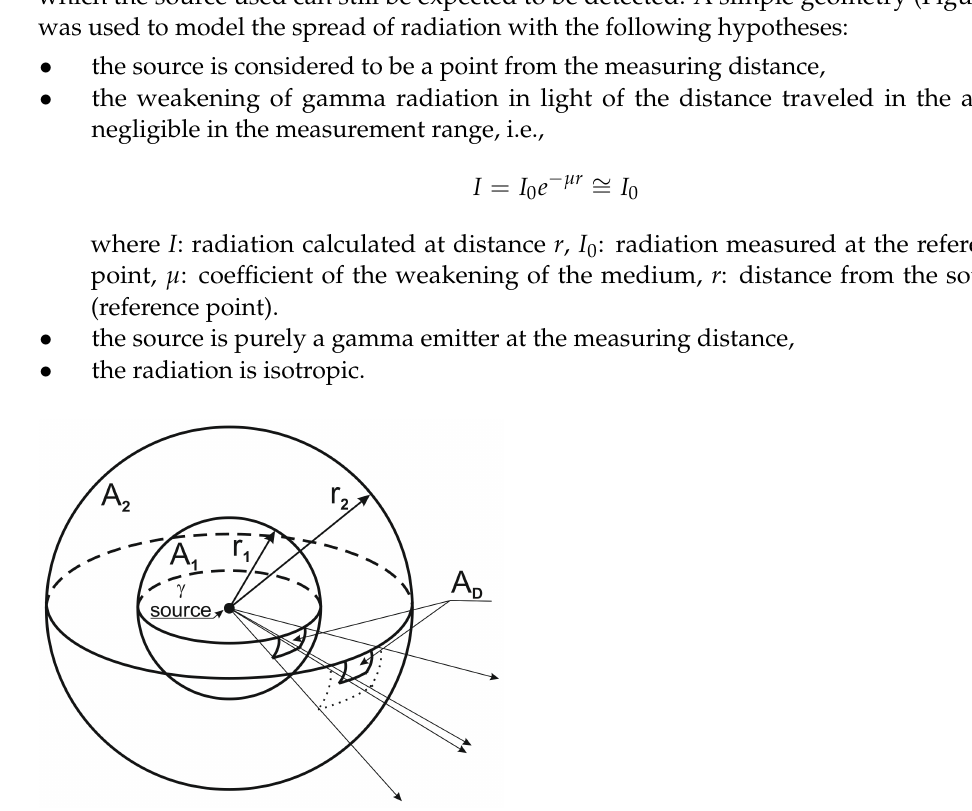
Figure 3. Modeling the distance-dependent detectability of the radiation. A D : the surface of the detector; A 1 : the surface of a sphere defining a unit distance; A 2 : the surface of the sphere determining the detection distance; r 1 : unit distance from the source; r 2 : detection distance from the